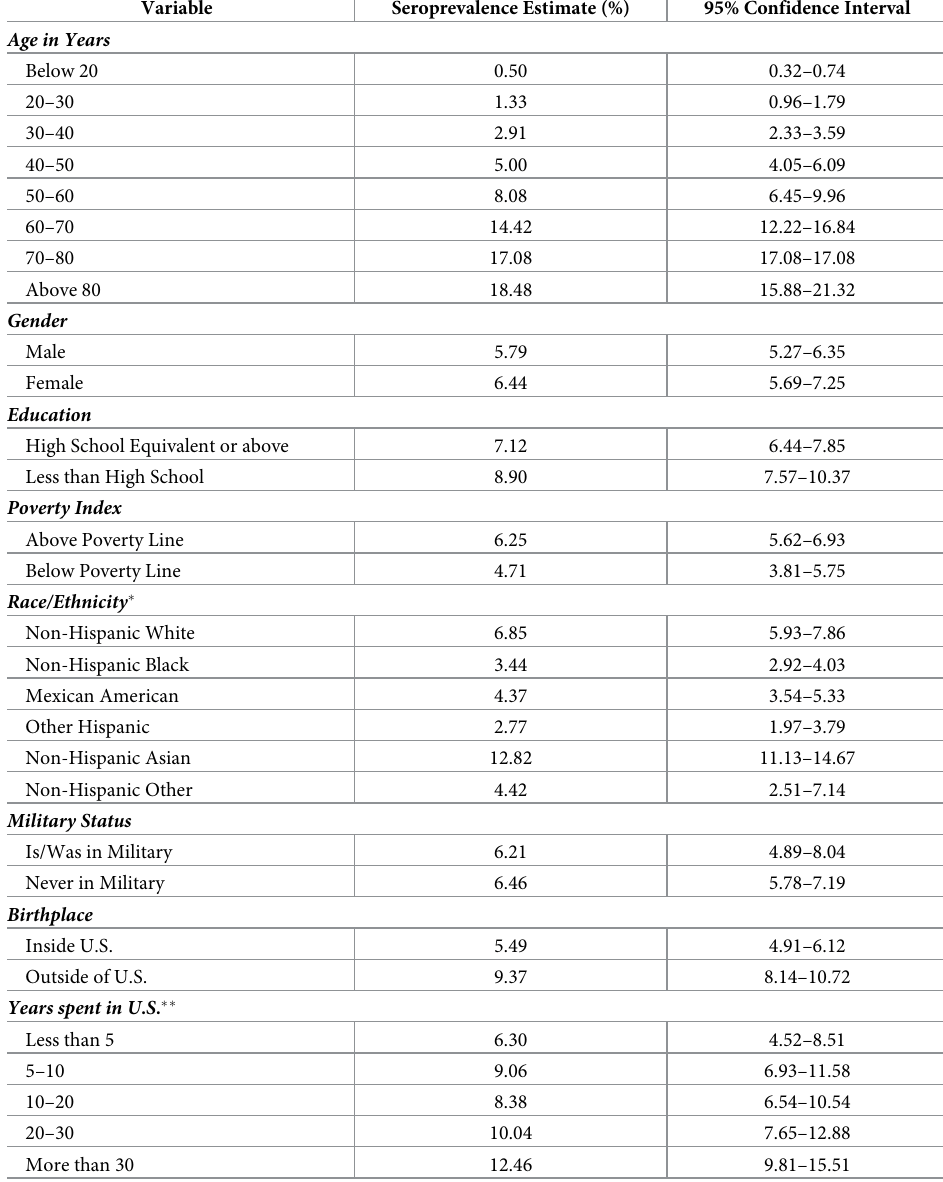
Table 2. Seroprevalence of HEV IgG in demographic groups in U.S. in continuous NHANES (2009–2016).